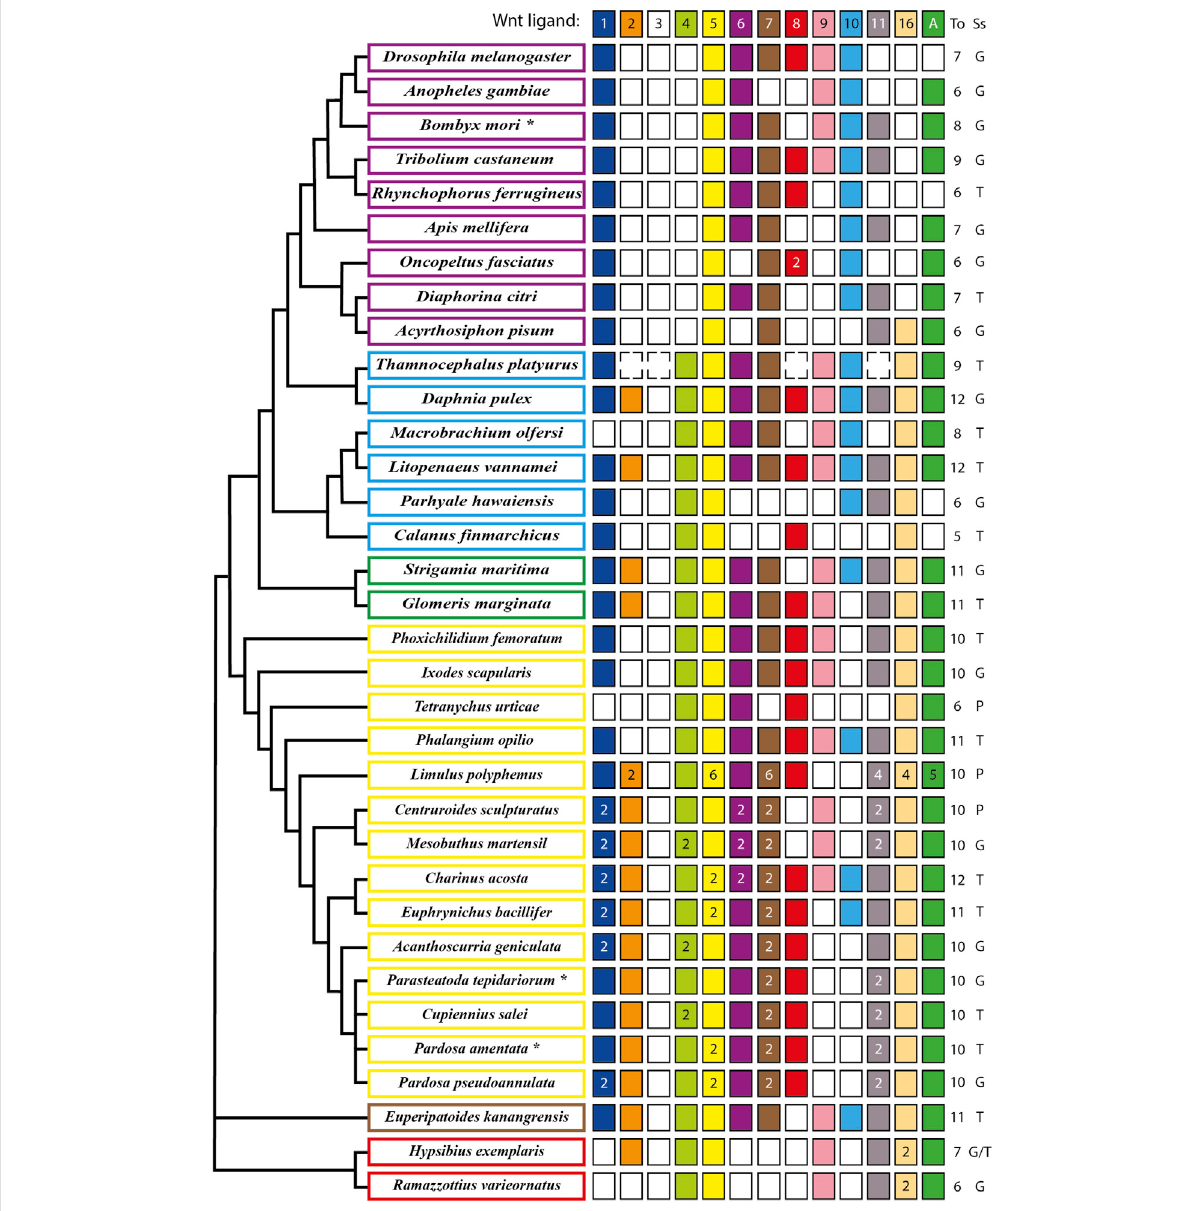
FIGURE 1 Updated repertoire and phylogeneticrelationship of Wnt ligands among panarthropods. Insects are shown in purple rectangles (Dearden et al., 2006; Bolognesi et al., 2008a; Murat et al., 2010; Shigenobu et al., 2010; Yin et al., 2015; Ding et al., 2019; Holzem et al., 2019; Pan fi lio et al., 2019; Vosburg et al., 2020), crustaceans in pale blue (Janssen et al., 2010; Constantinou et al., 2016; Jaramillo et al., 2016; Kao et al., 2016; Du et al., 2018), myriapods in green (Janssen et al., 2010; Hayden and Arthur, 2014; Janssen and Posnien, 2014), chelicerates in yellow (Janssen et al., 2010; Pace et al., 2014; Posnien et al., 2014; Harper et al., 2021; Janssen et al., 2021; Janssen and Eriksson, 2022), onychophoran in brown (Hogvall et al., 2014) and tardigrades in red (Chavarria et al., 2021). An asterisk in the name indicates more organisms having the same repertoire. * B. mori also includes Bicyclus anynana , Amyelois transitella , Calycopis cecrops , Danaus plexippus , Heliconius melpomene , Operophtera brumata and Papilioxuthus .* P.tepidariorum includes Pholcusphalangioides and* P.amentata includes Marpissamuscosa and Stegodyphusdumicola .Filled and no- fi lled boxes represent the presence and the absence of the ligand, respectively. Dotted boxes represent the presence/absence of the ligand in doubt (genome not fully sequenced) and white/black numbers inside the boxes represent ligand numbers. The Wnt ligand family is indicatedatthetopaswellasthetotal(To)numberofligandfamilies.Thesourceofthesequences(Ss)isshowedasGenome(G),Transcriptome (T) or Proteome (P). Phylogenetic positions based on Koenemann et al., 2010, Misof et al., 2014, Giribet and Edgecombe, 2019, Lozano- Fernandez et al., 2019 and Ballesteros et al.,